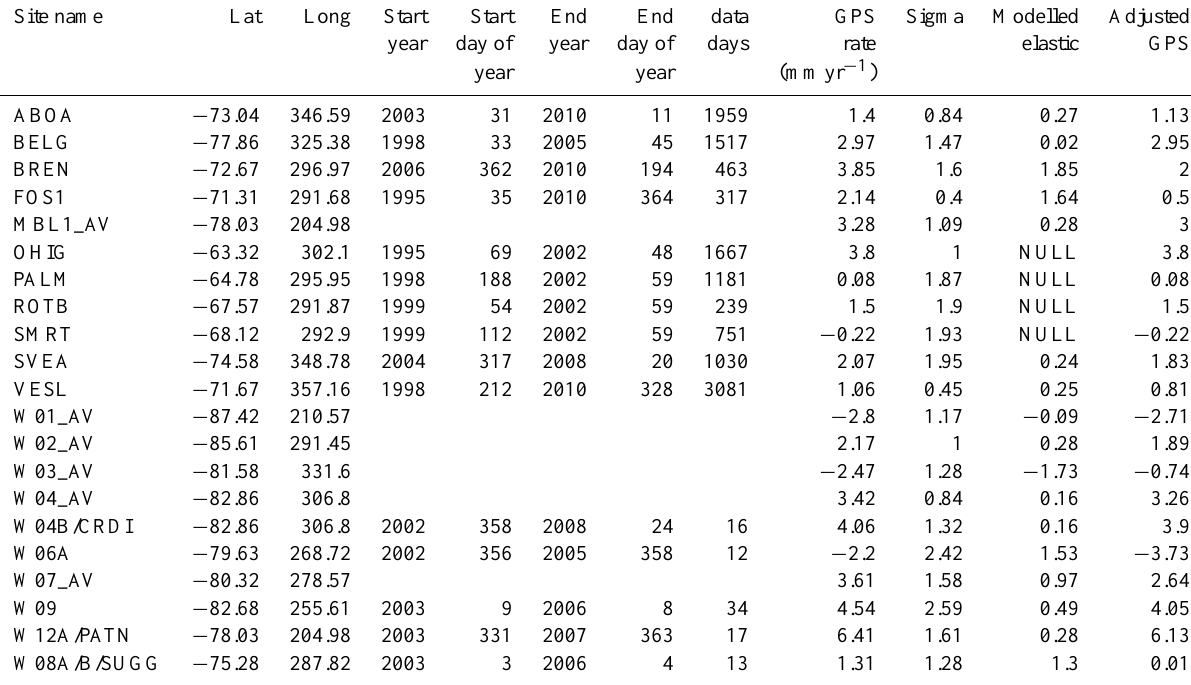
Table 1. GPS stations with vertical rate and errors, modelled elastic correction, and adjusted rates. The latter are used for inference. Site name